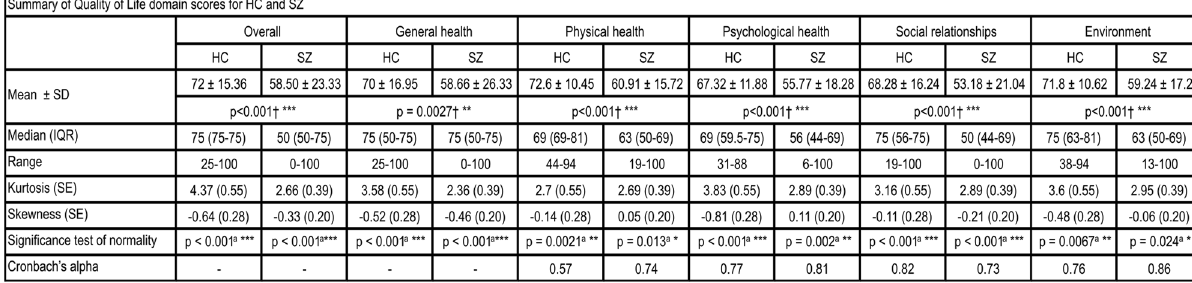
Figure 1. Summary of QoL items and domain scores prior to transformations—QoL scores are significantly higher in the healthy controls than patients with schizophrenia in all items. p-value (*p < 0.05**p < 0.01***p < 0.001) was calculated by † Mann–Whitney U-test, and a Shapiro–Wilk’s